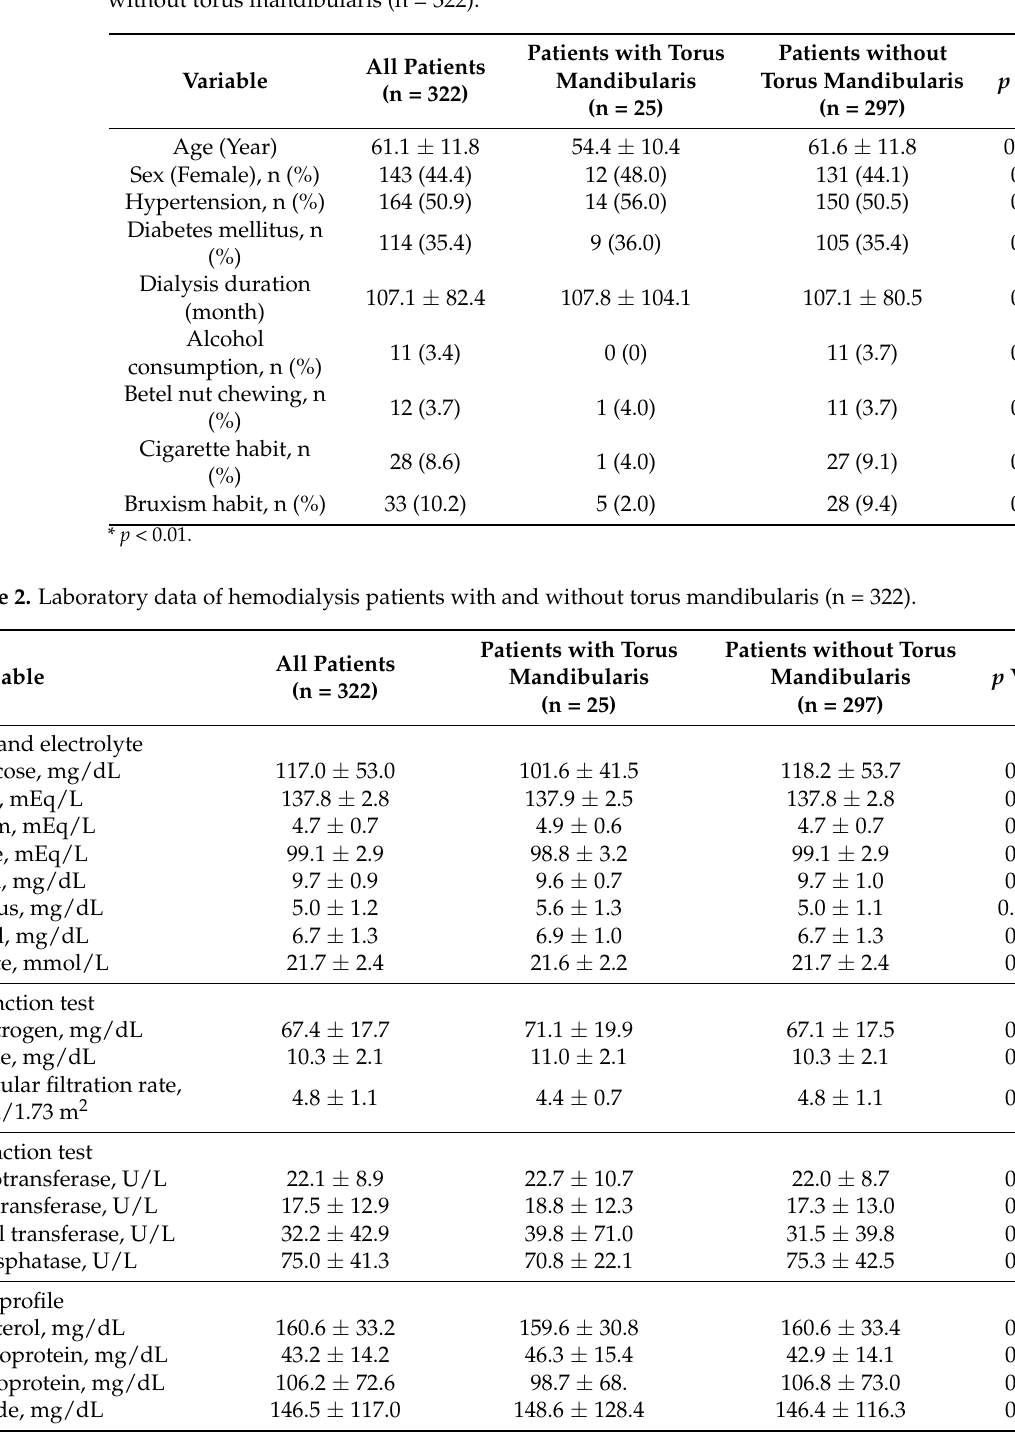
Table 1. The demographics, health conditions, and lifestyle factors of hemodialysis patients with and without torus mandibularis (n = 322).